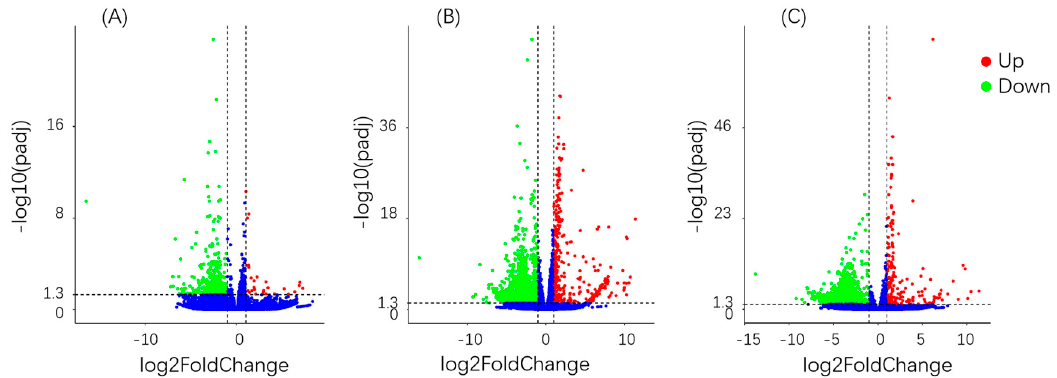
Figure 1. Di ff erential gene volcanoes at di ff erent time points. ( A ) at 6 h of fluazinam treatment compare to control, up: 28 genes, down: 487 genes; ( B ) at 24 h of fluazinam treatment compare to control, up: 368 genes, down: 1997 genes; ( C ) at 48 h of fluazinam treatment compare to control up: 191 genes, down: 1381